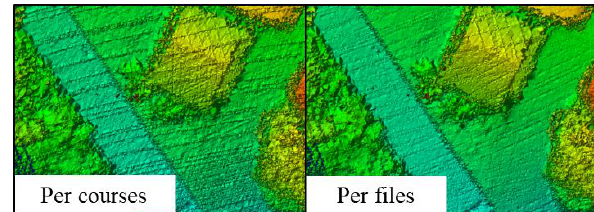
Figure 7. Results of adjustment between flying courses in the